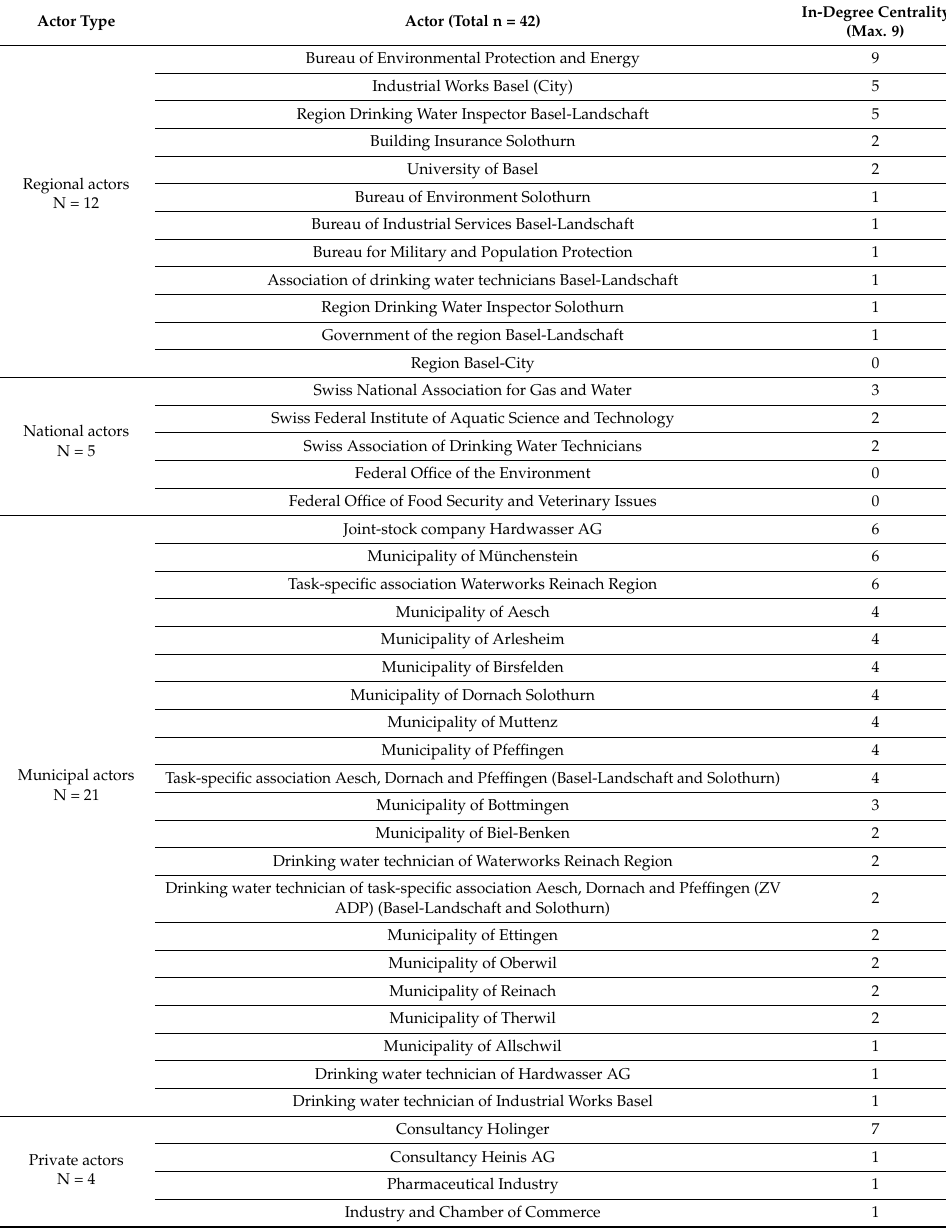
Table A3. In-degree centralities in Case